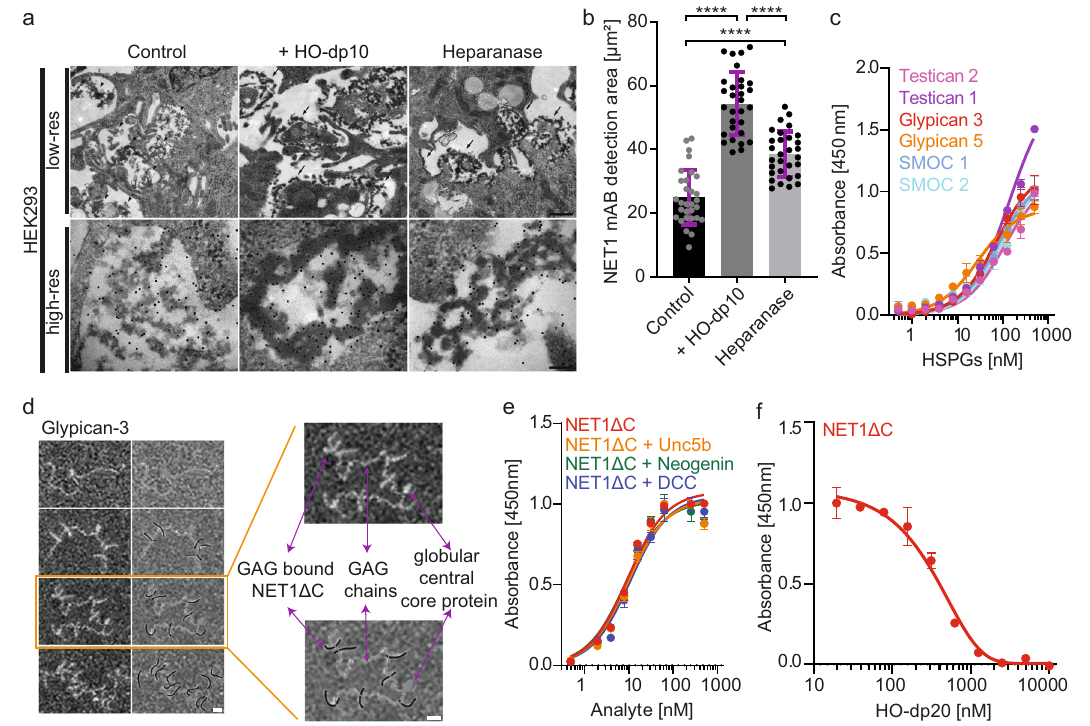
Fig. 1 | Localisation of NET1 Δ C on the cell surface and different patterns of NET1 Δ C-HSPG binding vs NET1 Δ C-GAG mediated interactions. a Transmission immune electron micrographs of ultrathin sections of HEK-293 cells over- expressing NET1 Δ C. A control image (left) is compared to addition of exogenous HO-dp10(middle)andHEK-293cellsoverexpressingofheparanase(right).Thetop and bottom row compare low- and high-resolution images. Black dots represent immune-gold labelled anti-NET1 mAB molecules depicting NET1 Δ C deposits. The scalebarsrepresent200nm(upper)and20nm(lower). b Statisticalanalysisofthe appearance of immuno-gold labelled anti-NET1 mAb on the HEK-293 cell surface were analysed by counting the gold particles/ μ m 2 on cellular pro fi les ( N =30). The results of an ordinary one-way ANOVA Tukey multiple comparisons test are indi- cated:****, P <0.0001.Meanandstandarddeviation(SD)areindicated. c ELISAstyle binding studies show protein-protein interactions of the heparan sulphate pro- teoglycans (HSPGs) glypican-3/5, SMOC-1/2, and testican-1/2 to immobilised NET1 Δ C protein. NET1 Δ C was coated and incubated with serial dilutions of strep- tagged HSPGs (0.5 – 500nM). Binding was detected using a strep-HRP antibody.